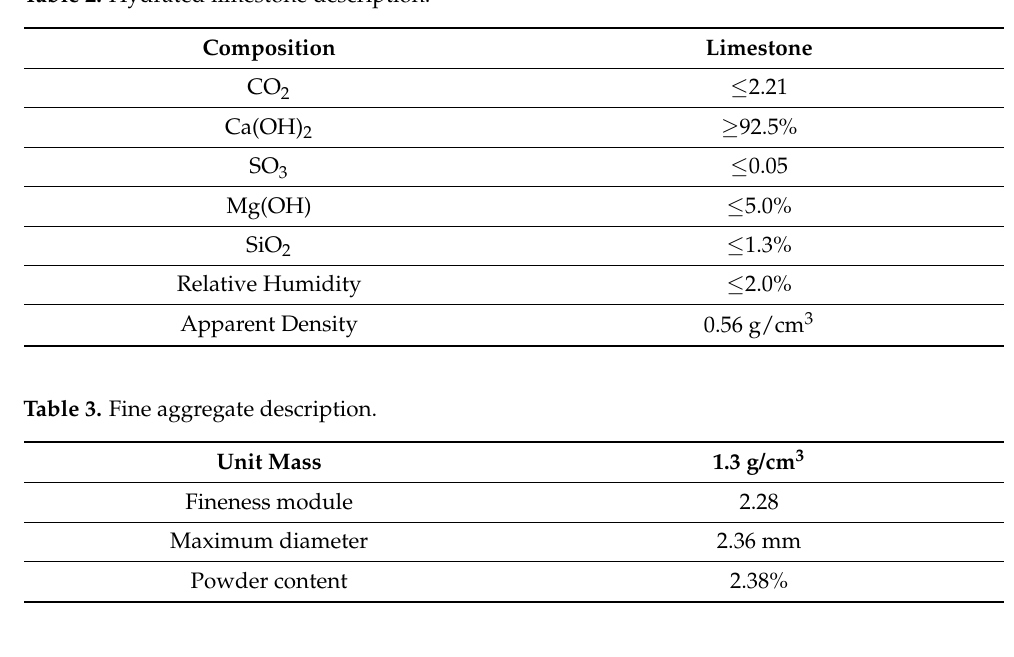
Table 2. Hydrated limestone description.